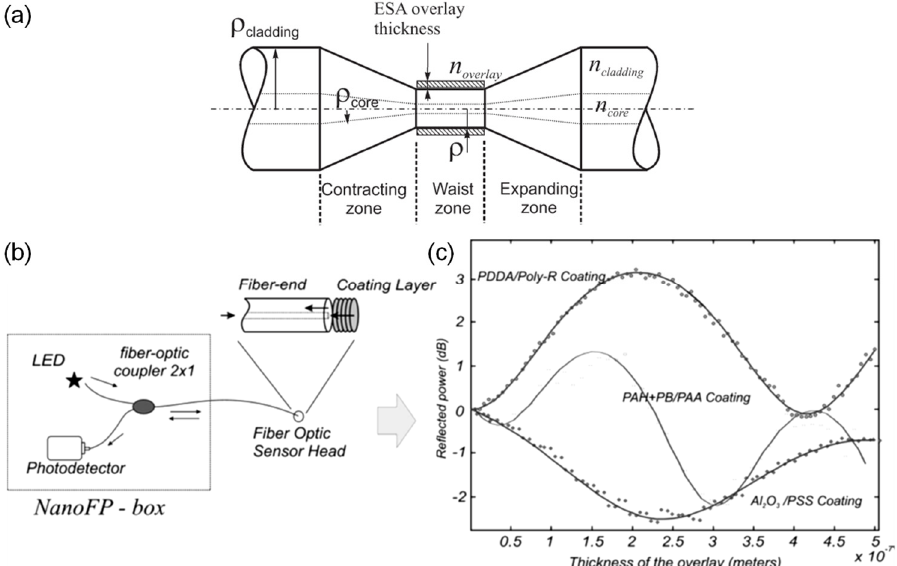
Figure 10. Point sensor. ( a ) Geometrical parameters of the fiber taper. ( b ) Experimental setup. ( c ) Reflected power as a function of overlay thickness. Reprinted with permission from [42] © IEEE .